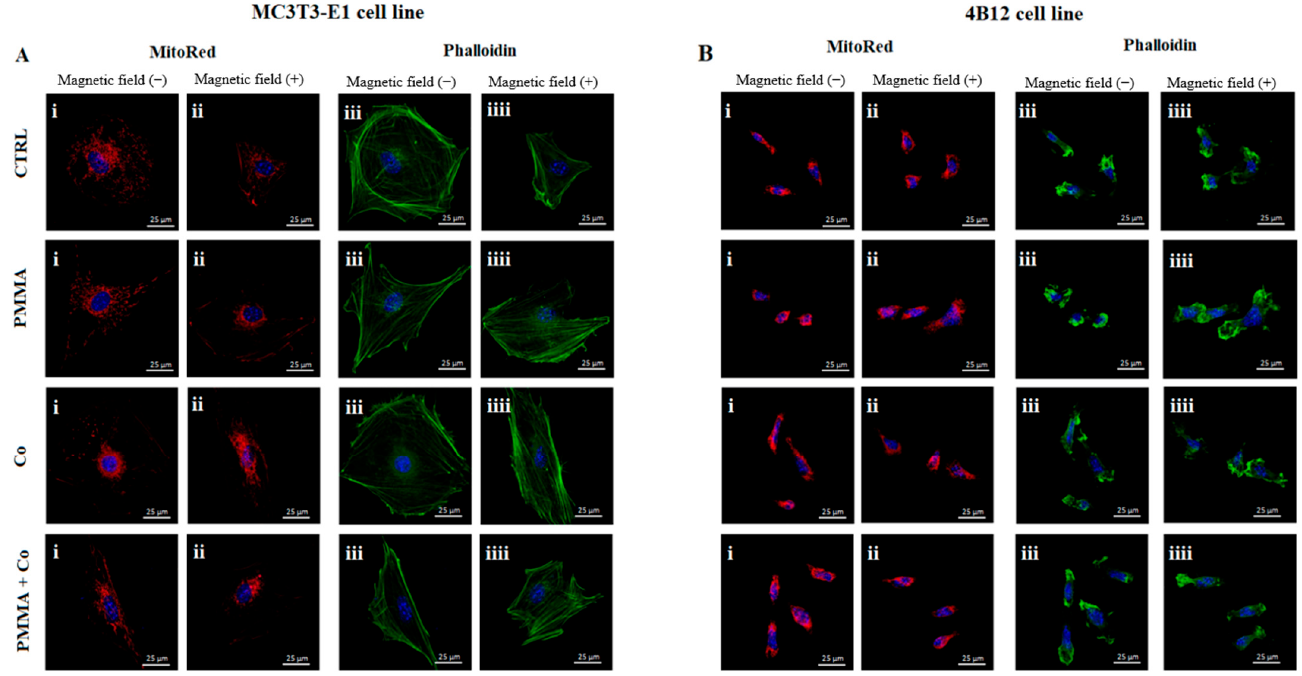
Figure 4. The impact of the PMMA and its modification on the mitochondria status and cytoskeleton in the MC3T3-E1 ( A ) and 4B12 ( B ) cell line in the presence of the magnetic field. Notes: CTRL—control, PMMA—poly(methyl (methylacrylate)), Co—Co 0.5 Mn 0.5 Fe 2 O 4 , PMMA+ Co—Co 0.5 Mn 0.5 Fe 2 O 4 @PMMA in ratio 80/20 .